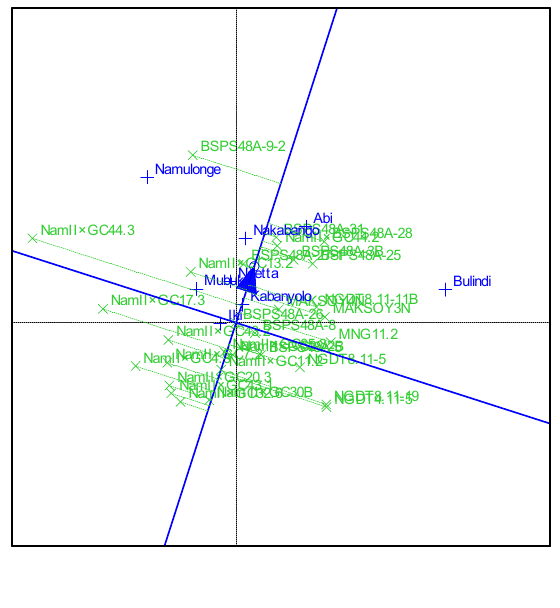
Figure 6. A GGE ranking biplot showing the mean performance and stability for the seed yields of 30 soybean genotypes evaluated in eight locations and six seasons.